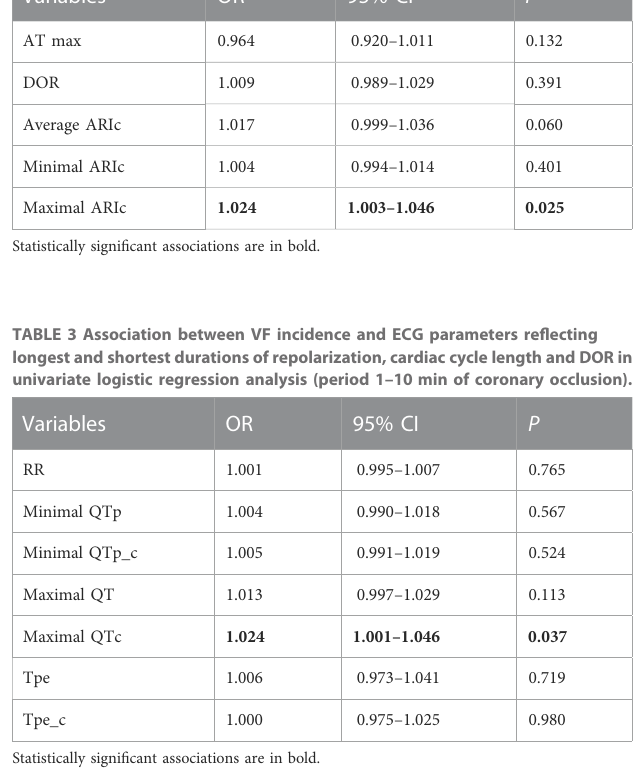
Statistically signi fi cant associations are in